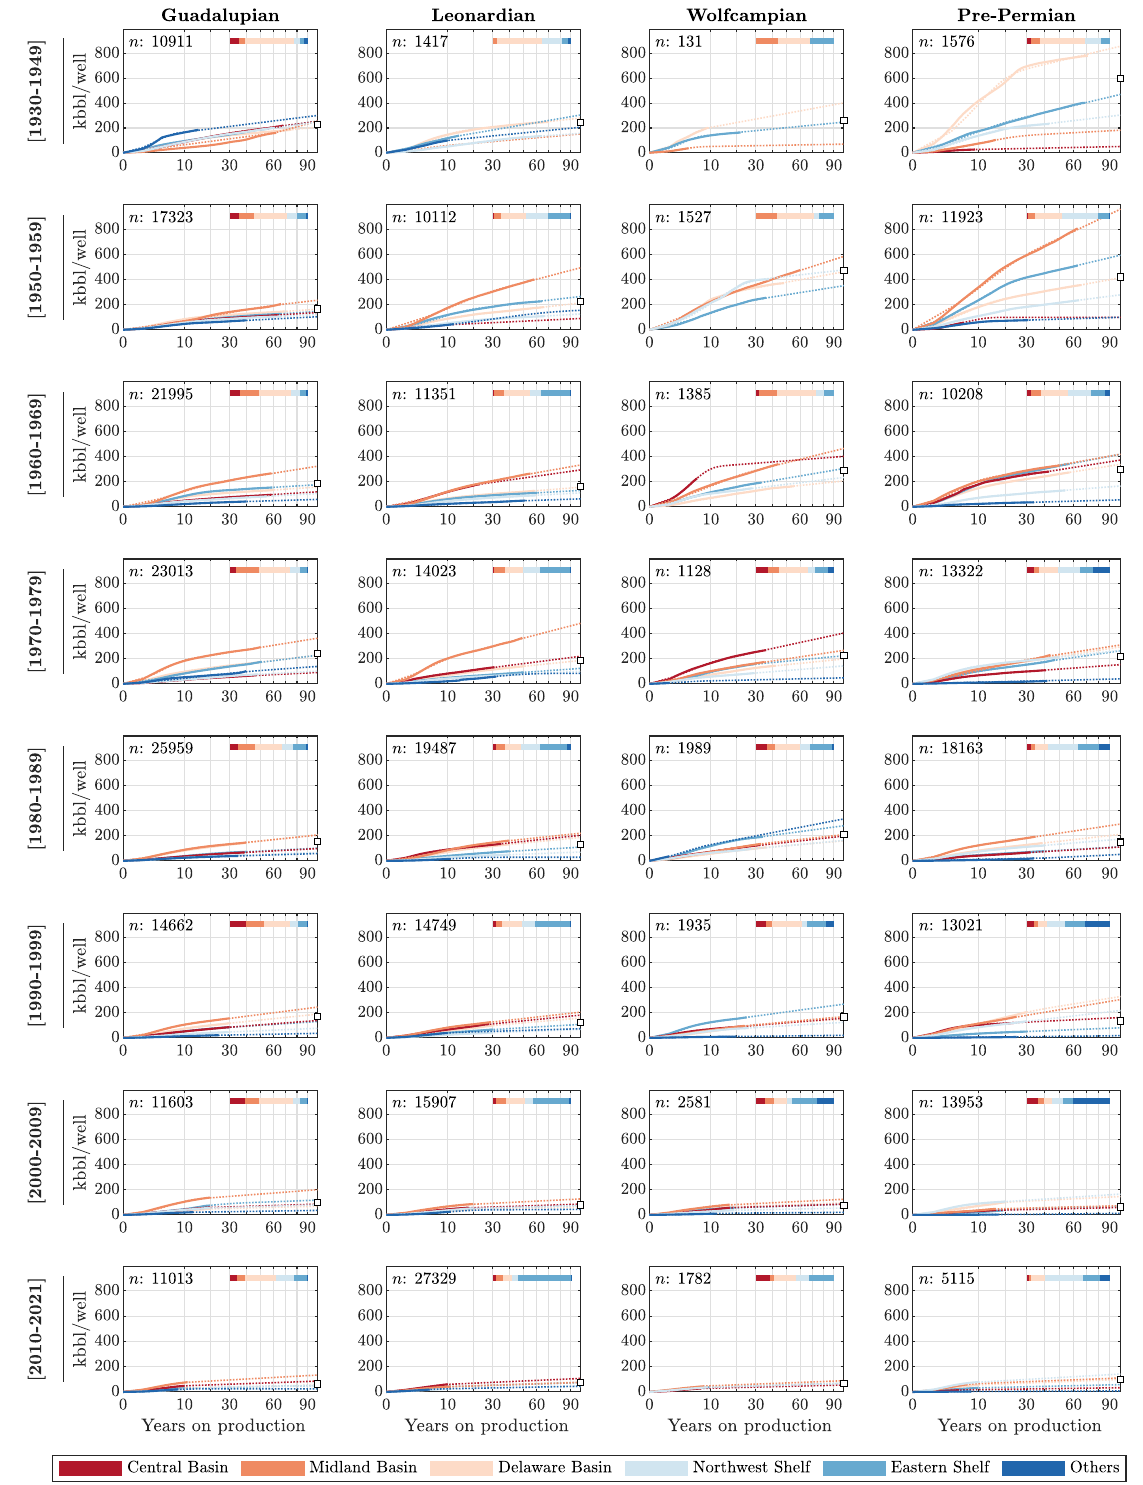
Figure 8. Historical well prototypes (solid lines) and the corresponding physical scaling forecasts (dashed lines) for the 192 well cohorts. The columns represent the four reservoir ages, while the rows denote the eight different completion date intervals. The six different sub-plays are encoded with different colors. The horizontal bar charts show the percentage of each subset sub-play from the total n sample of each reservoir-age × completion-date combination. In addition, the small square at the right boundary of each graph shows the average ultimate recovery for the six sub-play